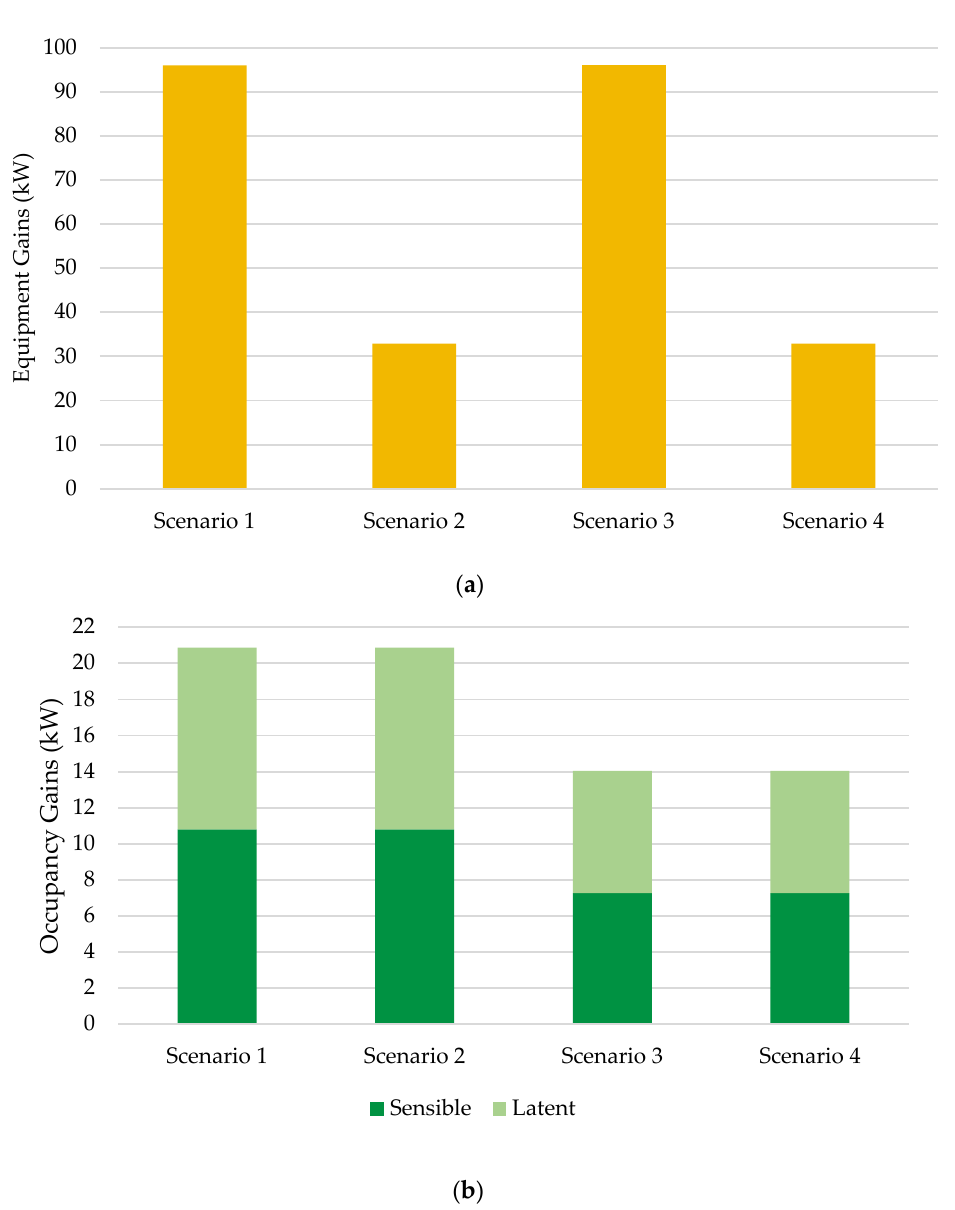
Figure 15. Predicted ( a ) equipment, and ( b ) occupancy (sensible and latent) gains in the case study building office space based on Scenarios 1–4.